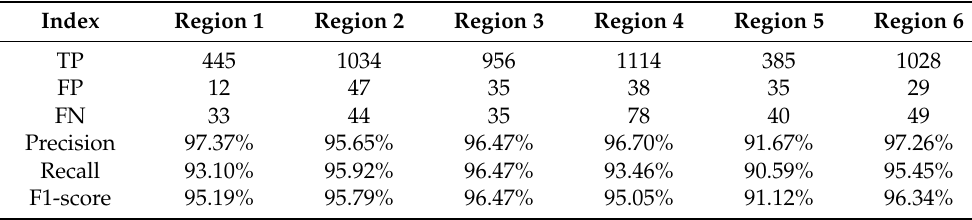
Table 1. The detection results of our proposed TS-CNN-based